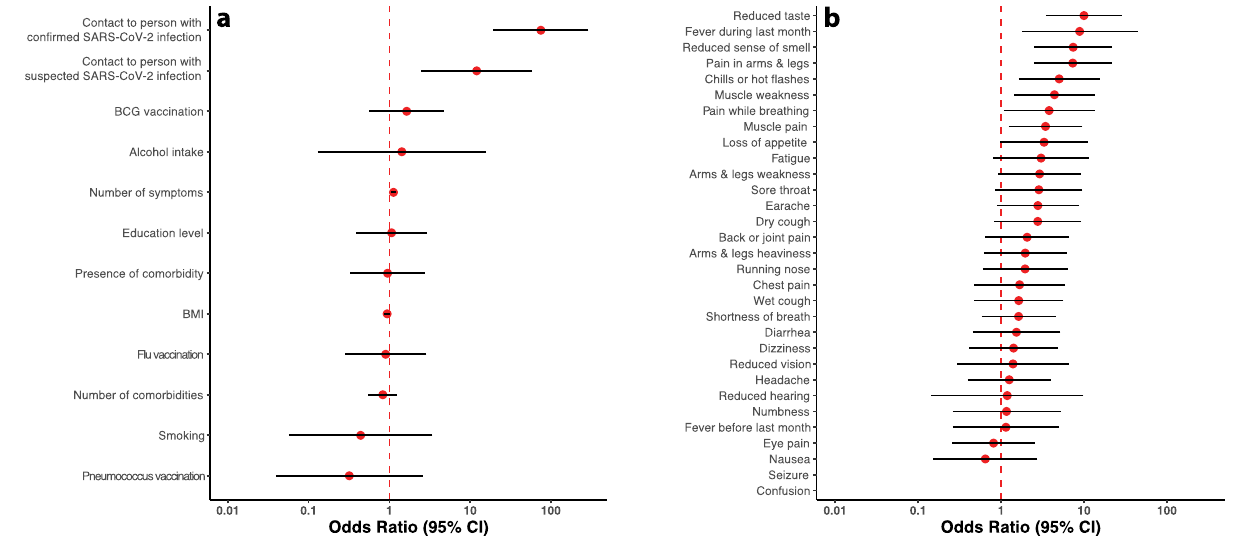
Fig. 2 Factors associated with the presence of neutralizing antibodies. a Living in the same household with a person with con fi rmed or suspected SARS- CoV-2 infection as well as a higher number of reported symptoms were signi fi cantly associated with the odds of having neutralizing antibodies . b A reduced sense of taste or smell, fever in the last month, pain in arm/legs, chills/hot fl ashes, pain while breathing as well as muscle weakness and pain were signi fi cantly more often reported by individuals with versus those without neutralizing antibodies; seizures and confusion were not reported in the seropositive group, and because of a very low background prevalence, the associated odds ratios could not be estimated reliably. The statistical comparisons were between 16 cases with mild-to-moderate symptoms who had SARS-CoV-2 neutralizing antibodies and 4754 individuals without SARS- CoV-2 (neutralizing) antibodies. All estimates are adjusted for age, sex and household clustering. The red dots represent the odds ratio point estimates, while the whiskers depict the corresponding 95% con fi dence intervals, on a logarithmic scale.